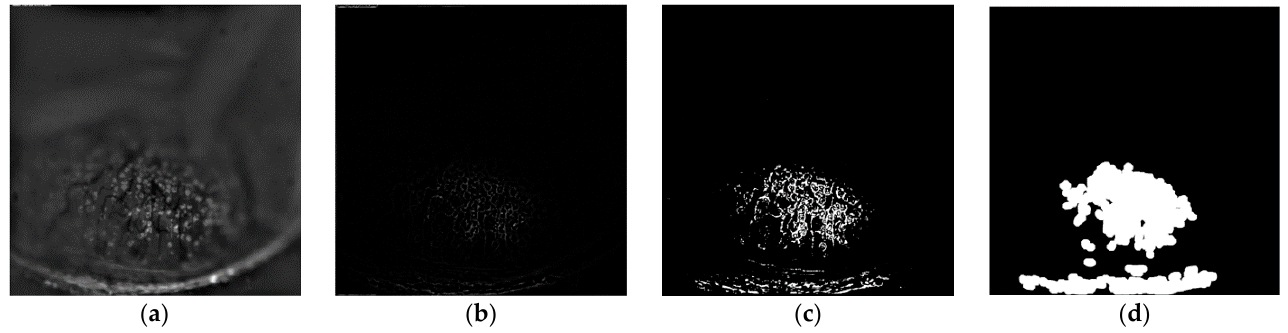
Figure 2. Results of local focus area detection. ( a ) Band-pass-filtered image, ( b ) Laplacian-filtered image, ( c ) thresholded image, and ( d ) dilated